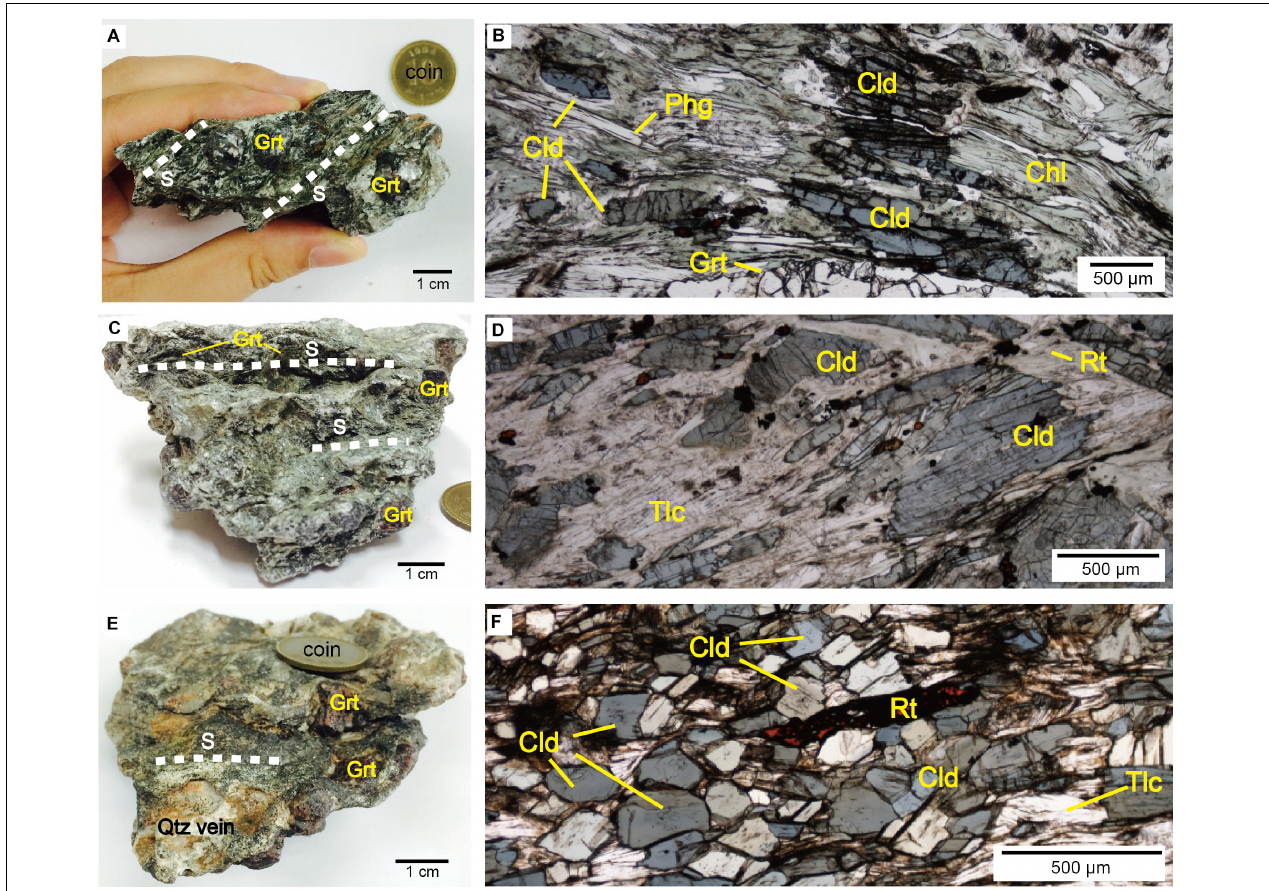
FIGURE 2 | Hand specimen (A,C,E) and plane-polarized microphotographs (B,D,F) of UHP Makbal garnet-chloritoid-talc schist samples. (A,B) sample #15R, (C,D) sample #10–16, (E,F) sample #12–52. In hand specimen, dashed lines denote the well-developed foliation (S). The lineation was determined on the foliation, by averaging directions of elongation of chloritoid and talc, and here parallel to the horizontal scale bar shown. Grt, garnet; Qtz, quartz; Cld, chloritoid; Tlc, talc; Rt,